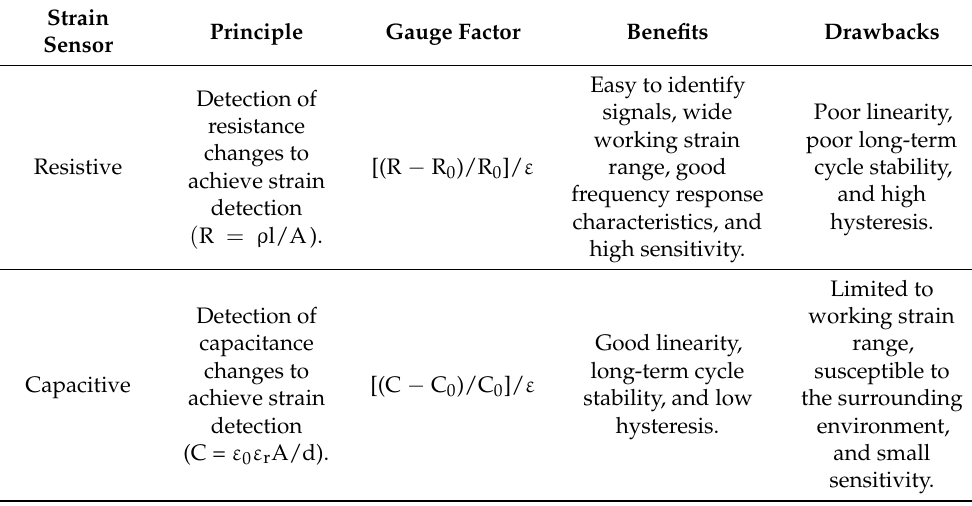
Table 2. Features of resistive and capacitive strain